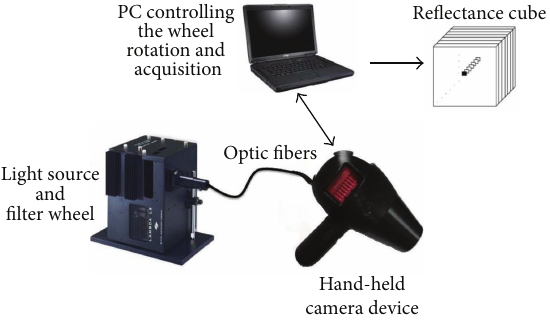
Figure 2: Description of the multispectral imaging system. The sys- tem is divided into two main parts: illumination device comprising oflightsourceandfilterwheelandahand-helddevicewithacamera. The system is controlled by a laptop and output reflectance cubes.